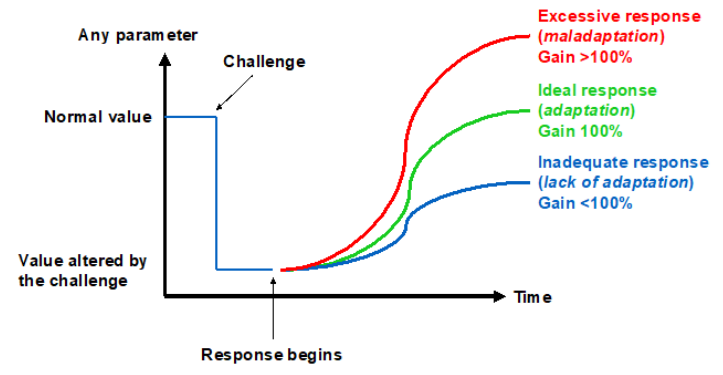
Figure 4. Three ways to respond to a